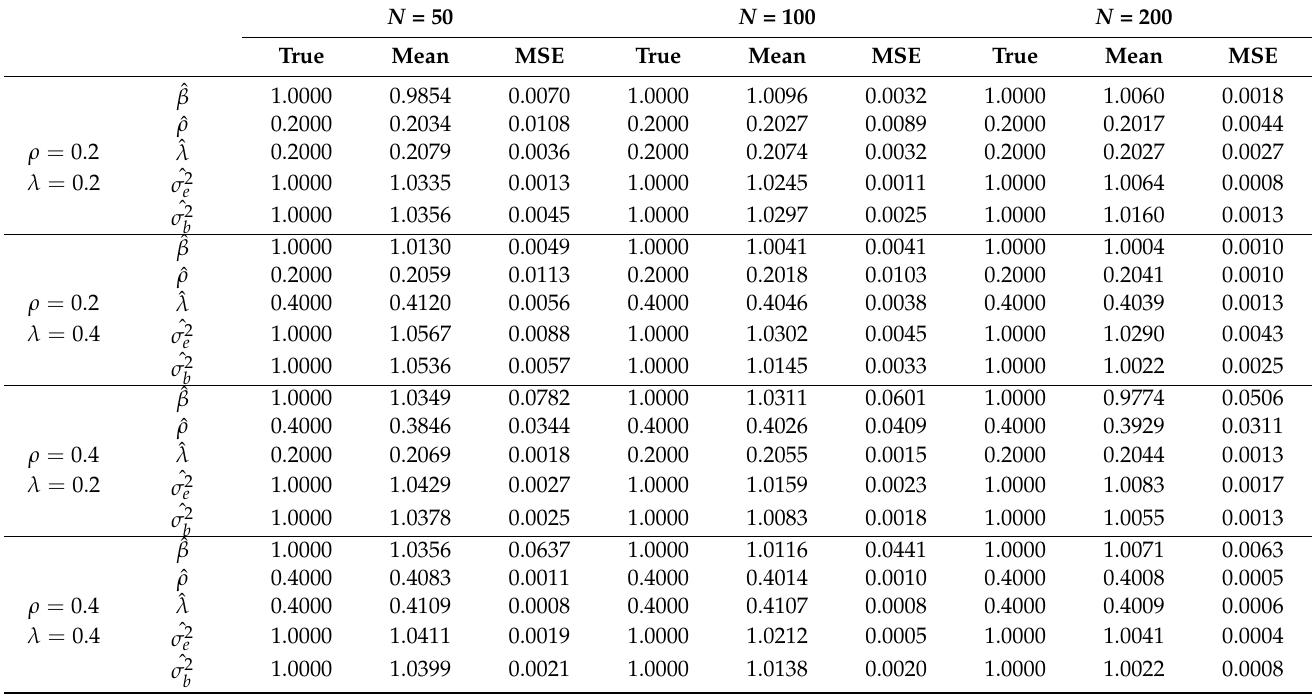
Table 1. Results of parametric estimates under the model (12) with T =